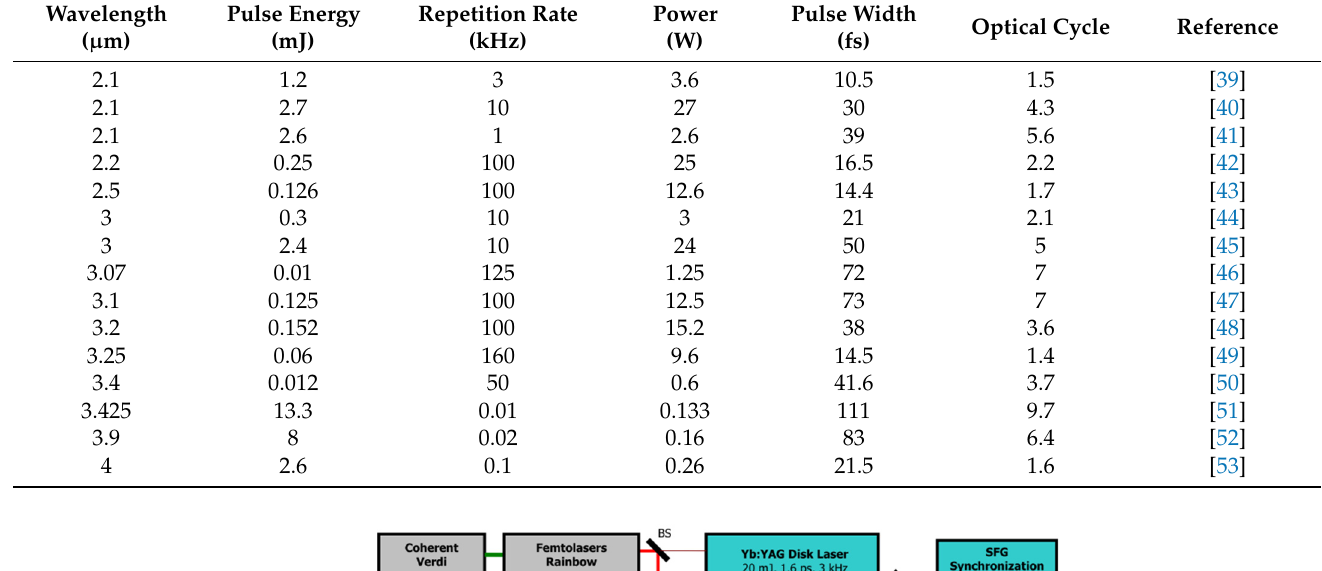
Table 3. Parameters of selected 2–4 µ m OPCPA system.